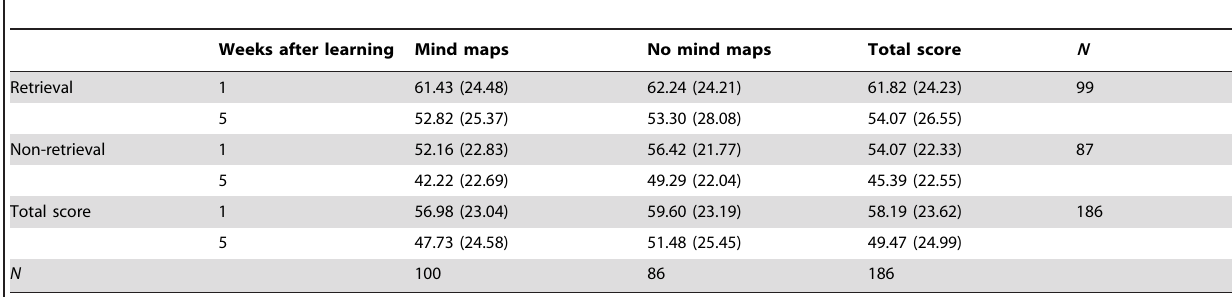
Table 2. Mean percentage scores (SDs) and sample sizes for the 1-week (white rows) and 5-week (shaded rows) recall tests (including only those who provided data at both